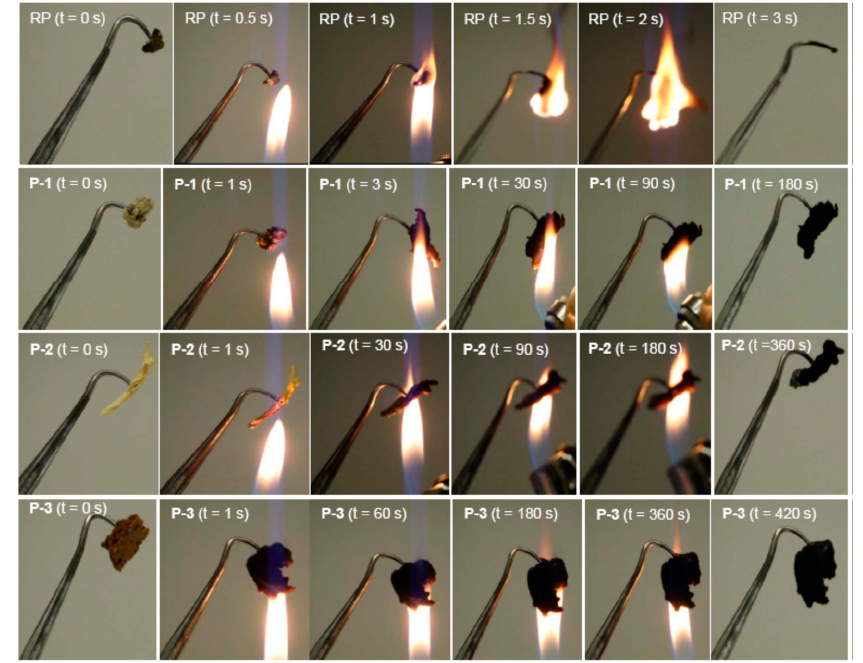
Figure 13. Photographs taken during direct flaming / combustion of a reference polymer ( RP ; top row) and ionic polymers ( P-1 , P-2 , and P-3 ) (bottom three